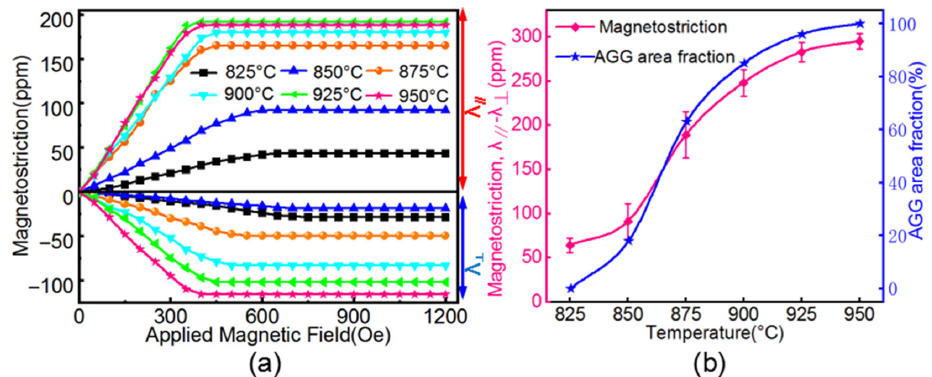
Figure 8. ( a ) Magnetostriction curves ( λ //, λ ⊥ ) against with magnetic field and ( b ) magnetostriction coefficients as a function of annealing temperature of the Fe81Ga19 thin sheet.